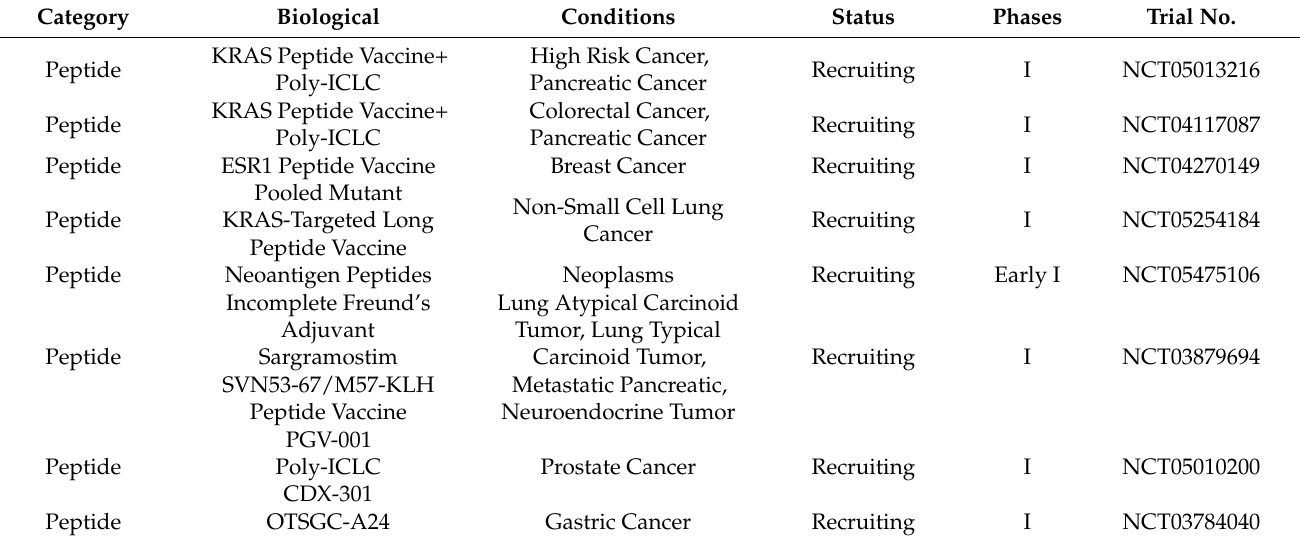
Table 4. Peptide-based cancer vaccines in clinical